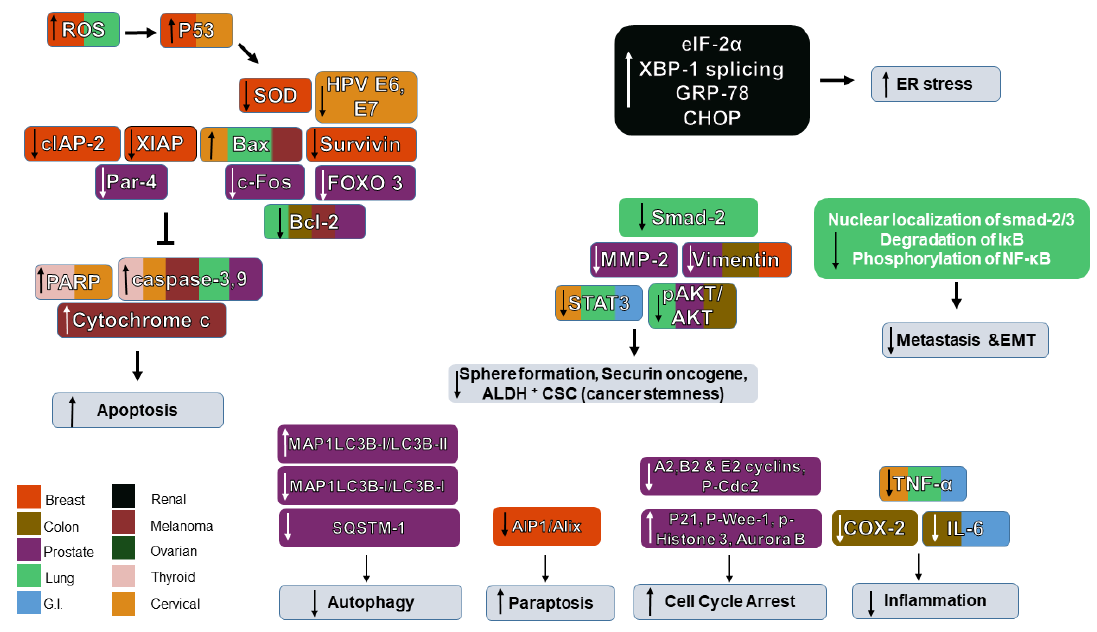
Figure 4. Schematic diagram of the role of Withaferin A in the signaling networks of various cancers and their associated protein regulation/dysregulation. “ ↑ ” denotes an increase, “ ↓ ” denotes decrease and “T” denotes inhibition.